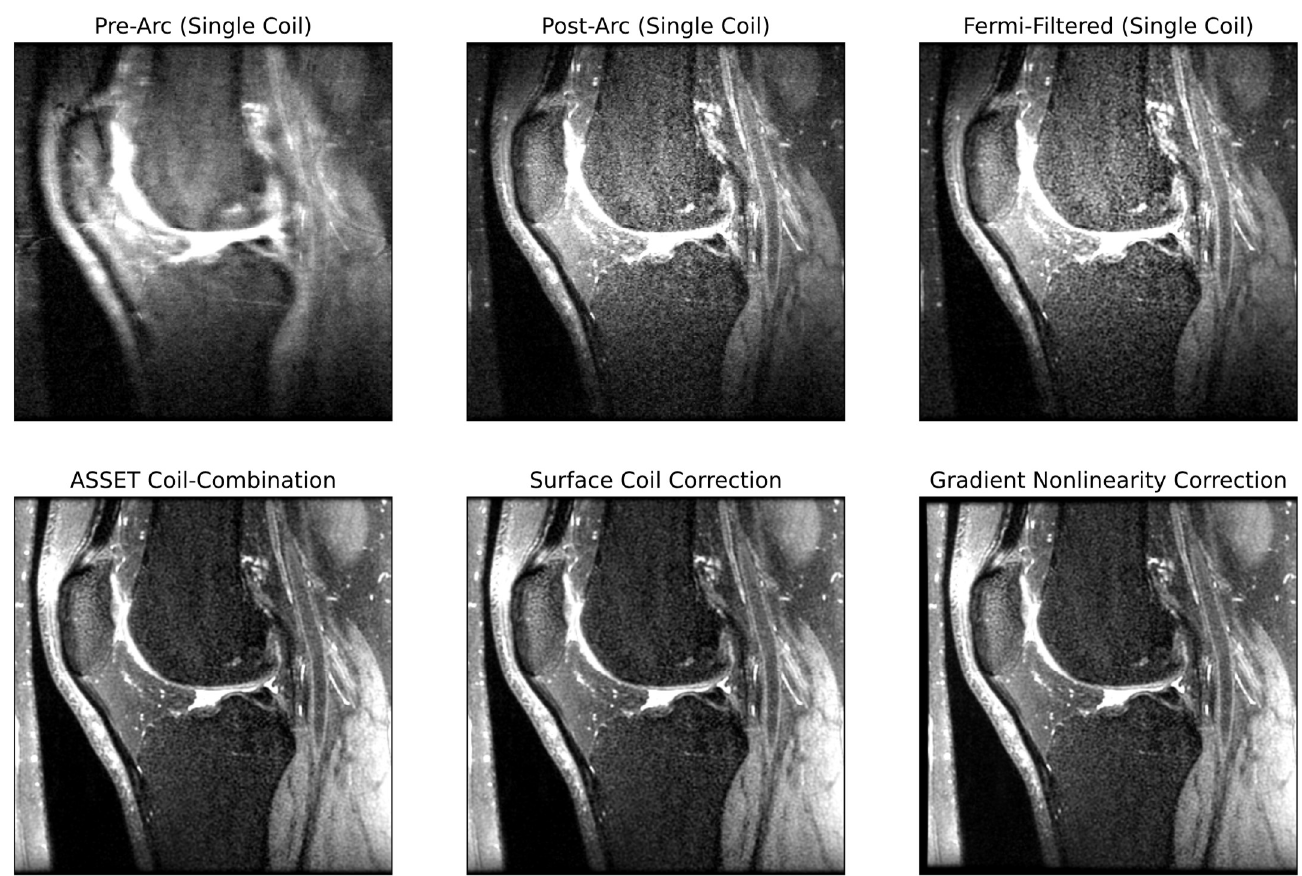
Figure 2. k-Space and image space post-processing steps for the in-house pipeline to reconstruct DICOM images from raw scanner data. Briefly, the steps in k-space are as follows: ARC reconstruction (parallel imaging), Fermi filtration to remove Gibbs artifacts, and zero-padding to bring the image to the intended output resolution. Image-space processing included coil combination, surface coil intensity correction, and gradient coil inhomogeneity correction.